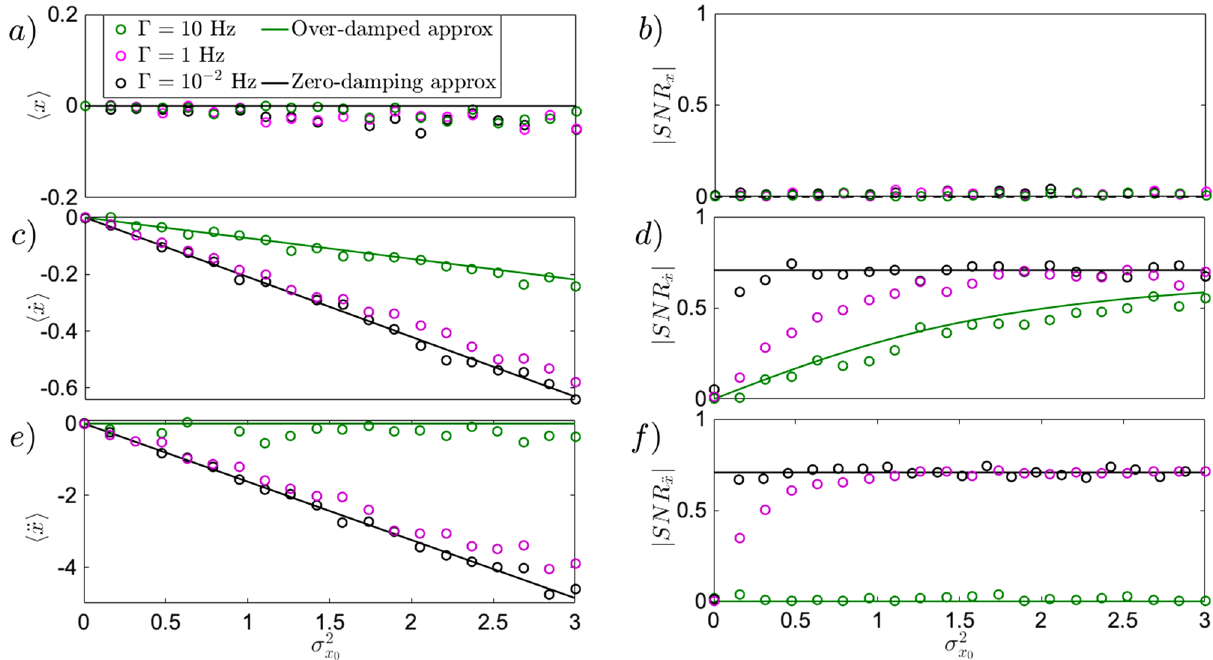
Figure 2. Uncertainty-induced effect for initially steady particle in position x (a,b) , instantaneous velocity x (c,d) , and acceleration x (e,f) , driven by variance σ 2 x 0 of initial position. All simulations (dots) have been ˙ ¨ 0.1 ms, the position statistics is performed based on Eq. (1). In the top panel, for a short time scale up to t = x trivial for all damping values, as the mean (a) does not develop with increasing initial uncertainty of position. (cid:31) (cid:30) Similarly, the SNR x (b) , is dominated by the noise spread and therefore vanishes. In the middle panel, (c) , the evolution of the mean of instantaneous velocity is displayed for different values of damping. At low damping, Ŵ 10 − 2 Hz (black dots), the deterministic limit (black line), as derived in Eq. (6), can be reached. On the = 10 Hz (green dots), the over-damped limit (green line), described other hand, for higher damping, namely Ŵ = ( K /Ŵ)σ 2 Ŵ v 1 Hz (purple dots), by the mean of average velocity x 0 is approached. The middle case of �¯ � ≈ − = x shows the sensitivity of mean of instantaneous velocity, , to the damping coefficient γ . Simultaneously, in (d) �˙ � the evolution of the SNR x depicts the role of the environmental temperature T for different pressures, showing ˙ a regime dominated by the latter (purple dots) denoted by a linear increase of the SNR x as discussed in Eq. (9). ˙ In the bottom panel, (e) , the mean of instantaneous acceleration is depicted for different pressures. While for x 10 − 2 Hz (black dots), the shift of mean instantaneous acceleration, small damping Ŵ , is visible and close = �¨ � 10 Hz (green dots), to the deterministic limit (black line), given in Eq. (5). It vanishes for larger damping Ŵ = where no instantaneous acceleration exists, (f) depicts, by contrast, the role of the environmental temperature T 2 recognisable in the SNR x by the linear dependency in σ x 0 of initial position, to be less present even at damping ¨ Ŵ 1 Hz, in comparison to the case for velocity, as shown in Eq. (10). Eq. (1) has been simulated using = 5 κ 6 k B T µ m − 3 Kg − 1 , T 300 K (ambient temperature), x 0 x 0 0 , 0 , σ x 0 = 0 , t = 0.1 ms, dt = 2 × 10 − = = � � = �˙ � = ˙ v , a , the ms. 10 4 trajectories where generated with 5000 samples each. To compute the average quantities, ¯ ¯ dt 10 multiple time-step has been used, δ t = ×